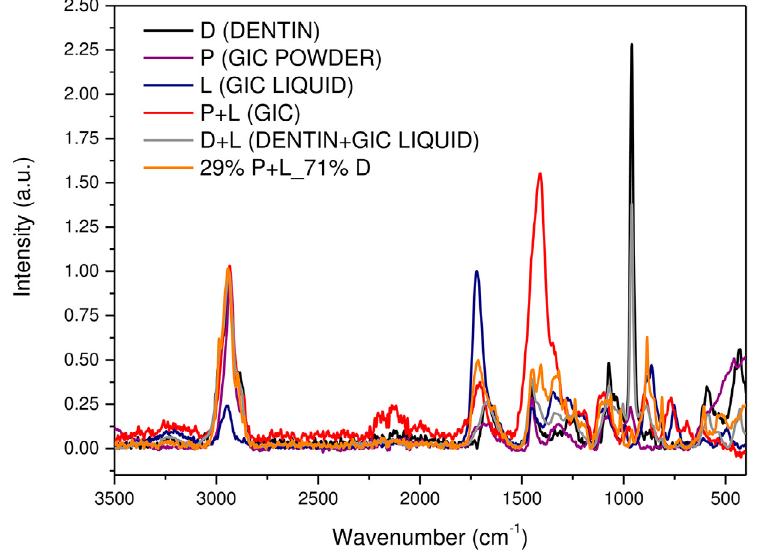
Figure 4- Raman spectra of the precursors: glass-ionomer cement’s (GIC) powder (P), GIC’s liquid (L) and dentin (D). GIC’s combinations (P+L), dentin with the GIC’s liquid (D+L) and the sample of 29% P+L_71% D